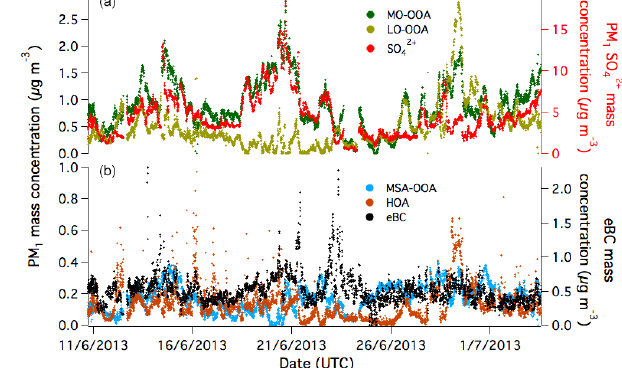
Figure 6. The time series of the PM 1 more oxidized OOA (MO-OOA), less oxidized (LO-OOA) and sulfate (a) and methanesulfonic-acid-related OOA (MSA-OOA), hydrocarbon-like OA (HOA) and eBC (b)